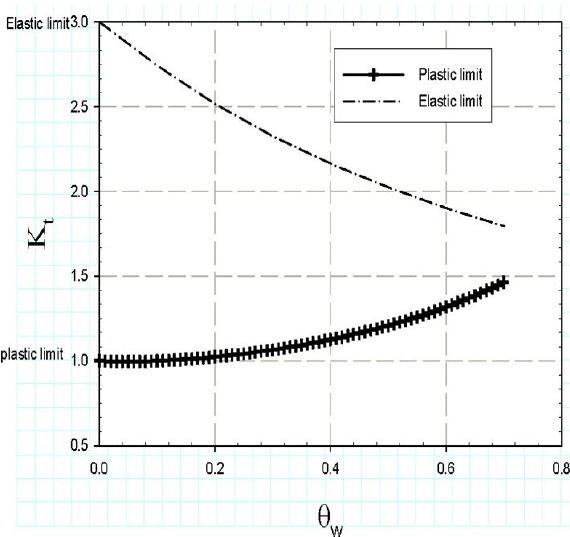
Table 5. FEM validation.